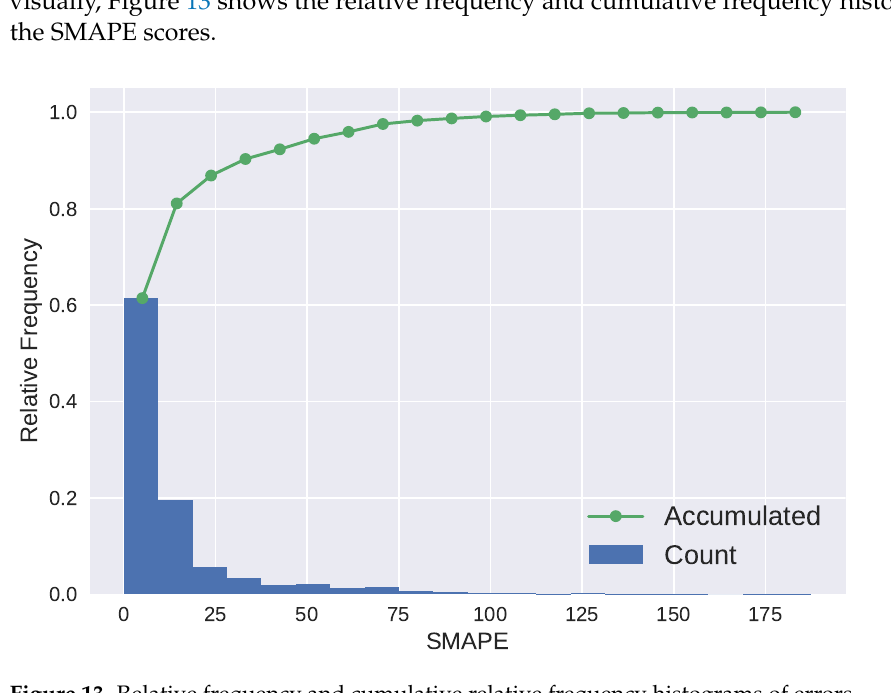
Figure 13. Relative frequency and cumulative relative frequency histograms of